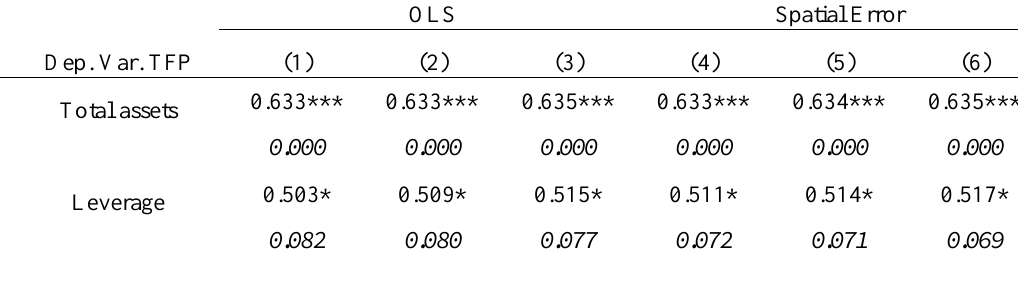
Table 4: Urban Domestic Productivity Determinants: The Electricity Distribution